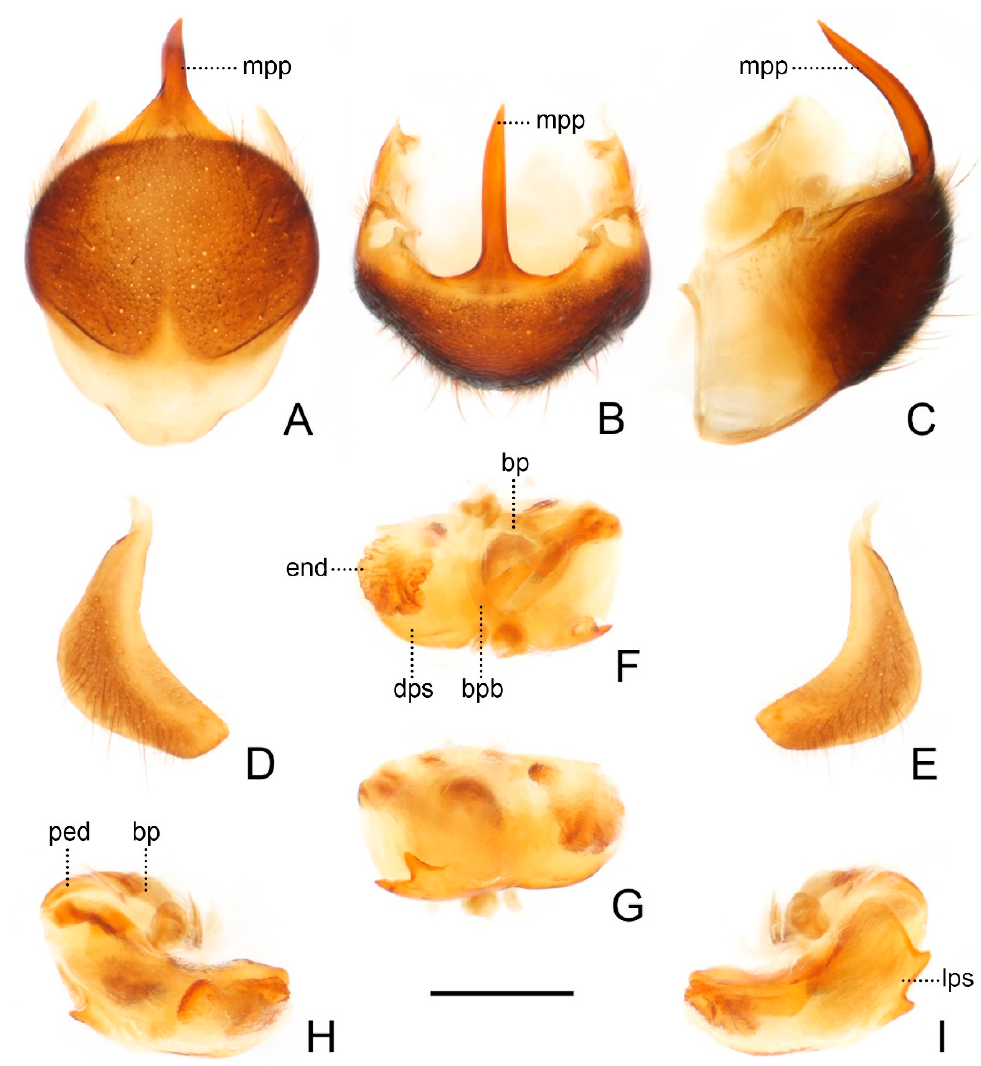
Figure 9. Male genitalia of Sigicoris dominiqueae sp. nov. , paratype. ( A ) Pygophore, ventral view; ( B ) ditto, caudal view; ( C ) ditto, lateral view. ( D ) Left paramere, outer ventrolateral view. ( E ) Right paramere, outer ventrolateral view. ( F ) Phallus, dorsal view; ( G ) ditto, ventral view; ( H ) ditto, left lateral view; (I) ditto, right lateral view. Scale bar = 0.50 mm. Abbreviations: bp, basal plate; bpb, basal plate bridge; dps, dorsal phallothecal sclerite; end, endosoma; lps, lateral phallothecal sclerite; mpp, median pygophore process; ped, pedicel.